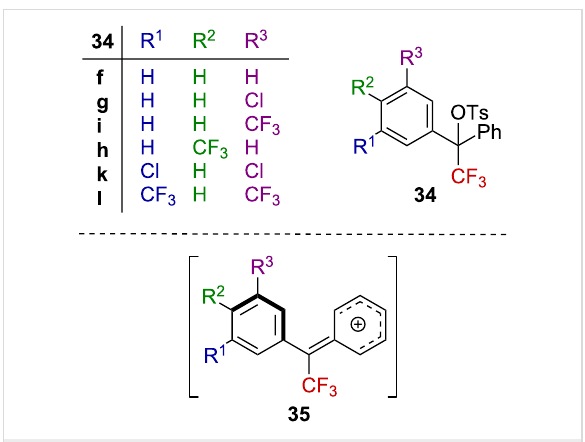
Figure 6: Structure of bisarylated derivatives 34 .